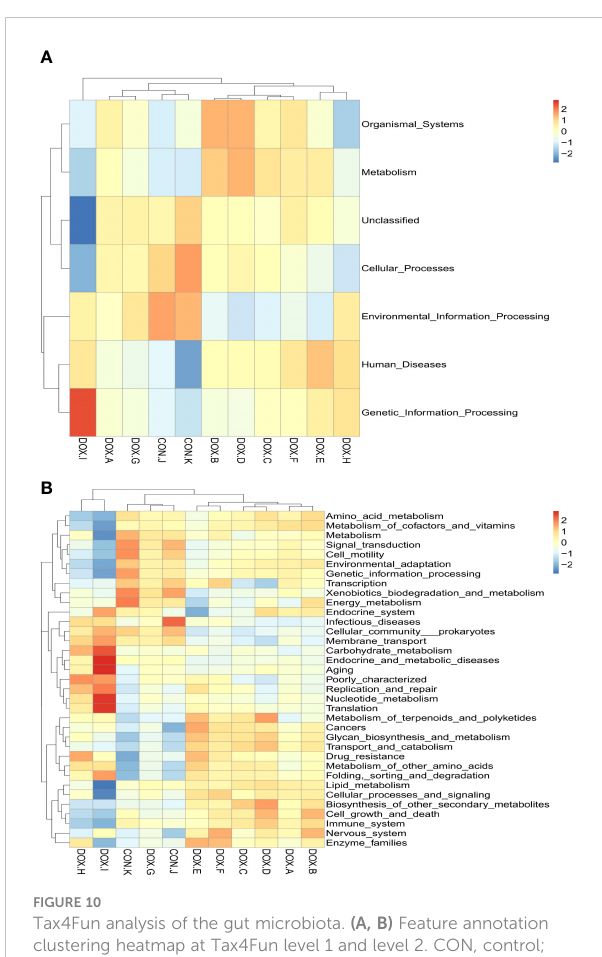
FIGURE 10 Tax4Fun analysis of the gut microbiota. (A, B) Feature annotation clustering heatmap at Tax4Fun level 1 and level 2. CON, control; DOX,